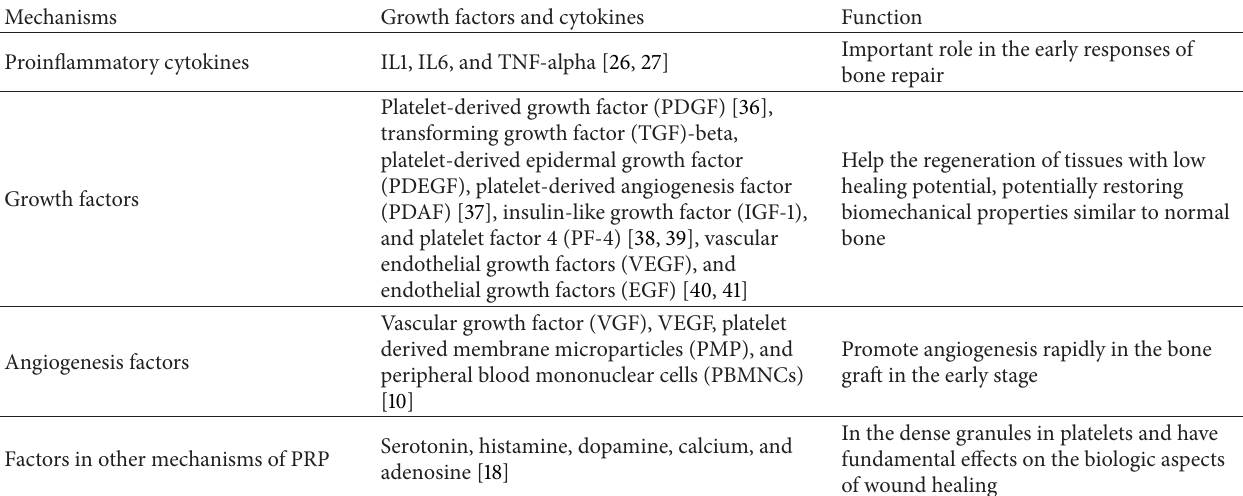
Table 1: Growth factors and cytokines in PRP in different